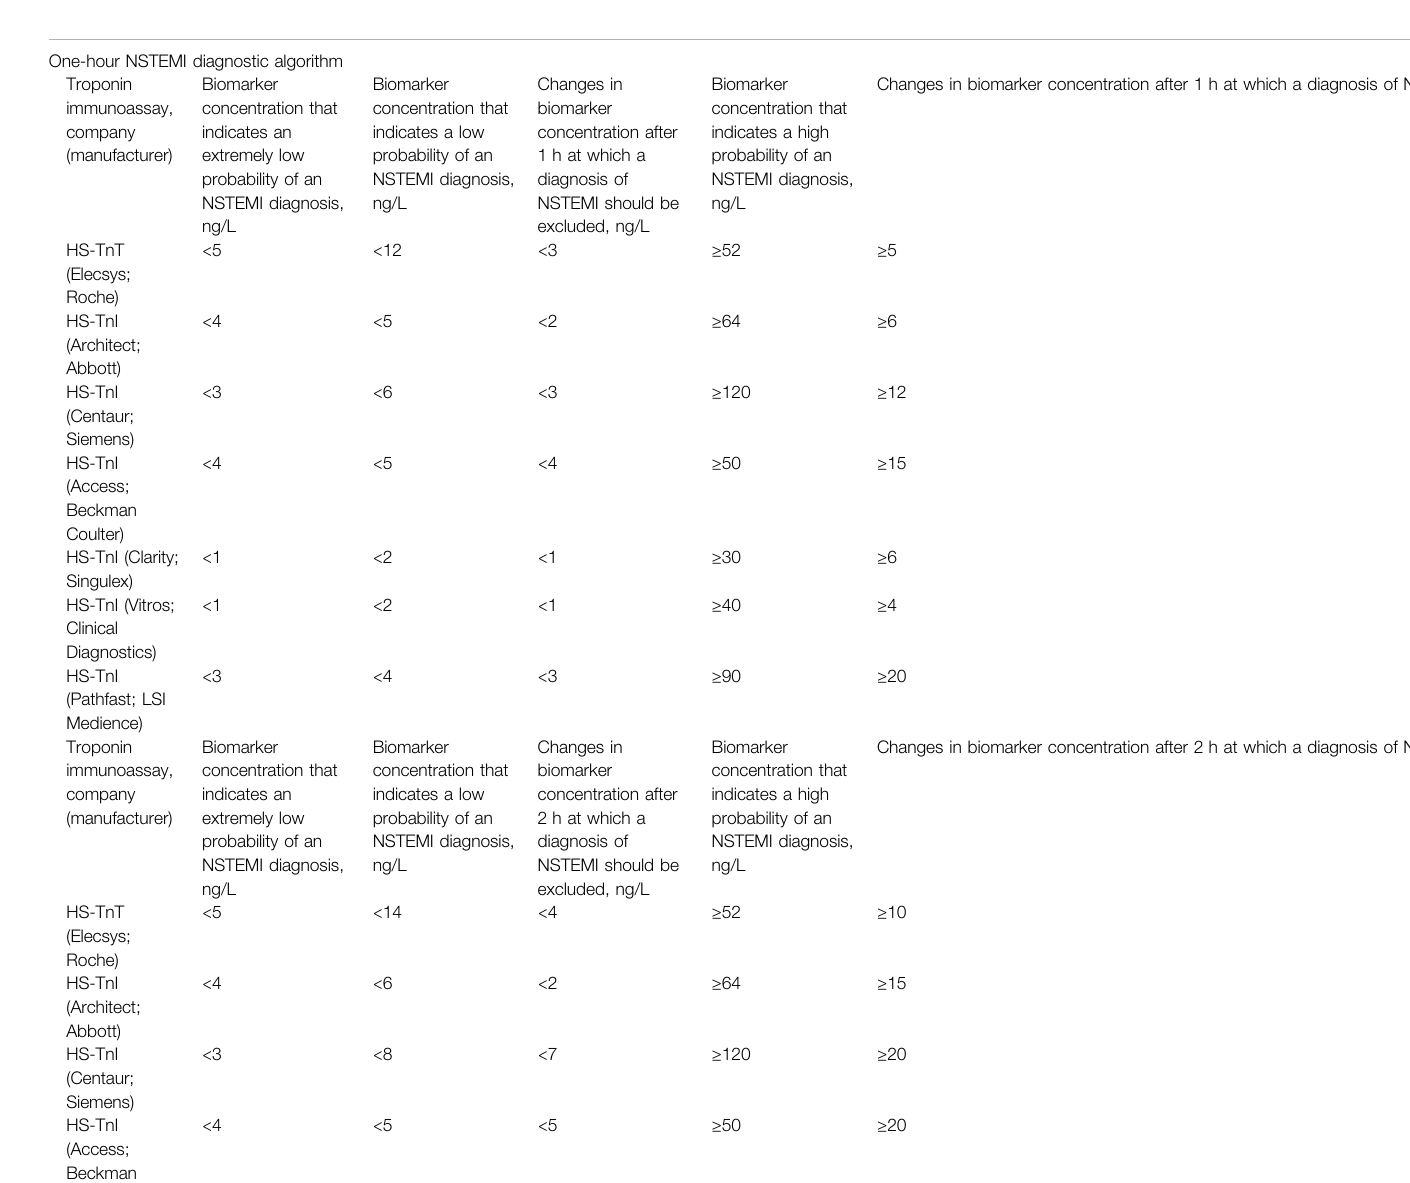
TABLE 1 | Current diagnostic algorithms for con fi rmation/exclusion of NSTEMI (0 → 1 h and 0 → 2 h), approved by the ESC (Collet et al., 2021).